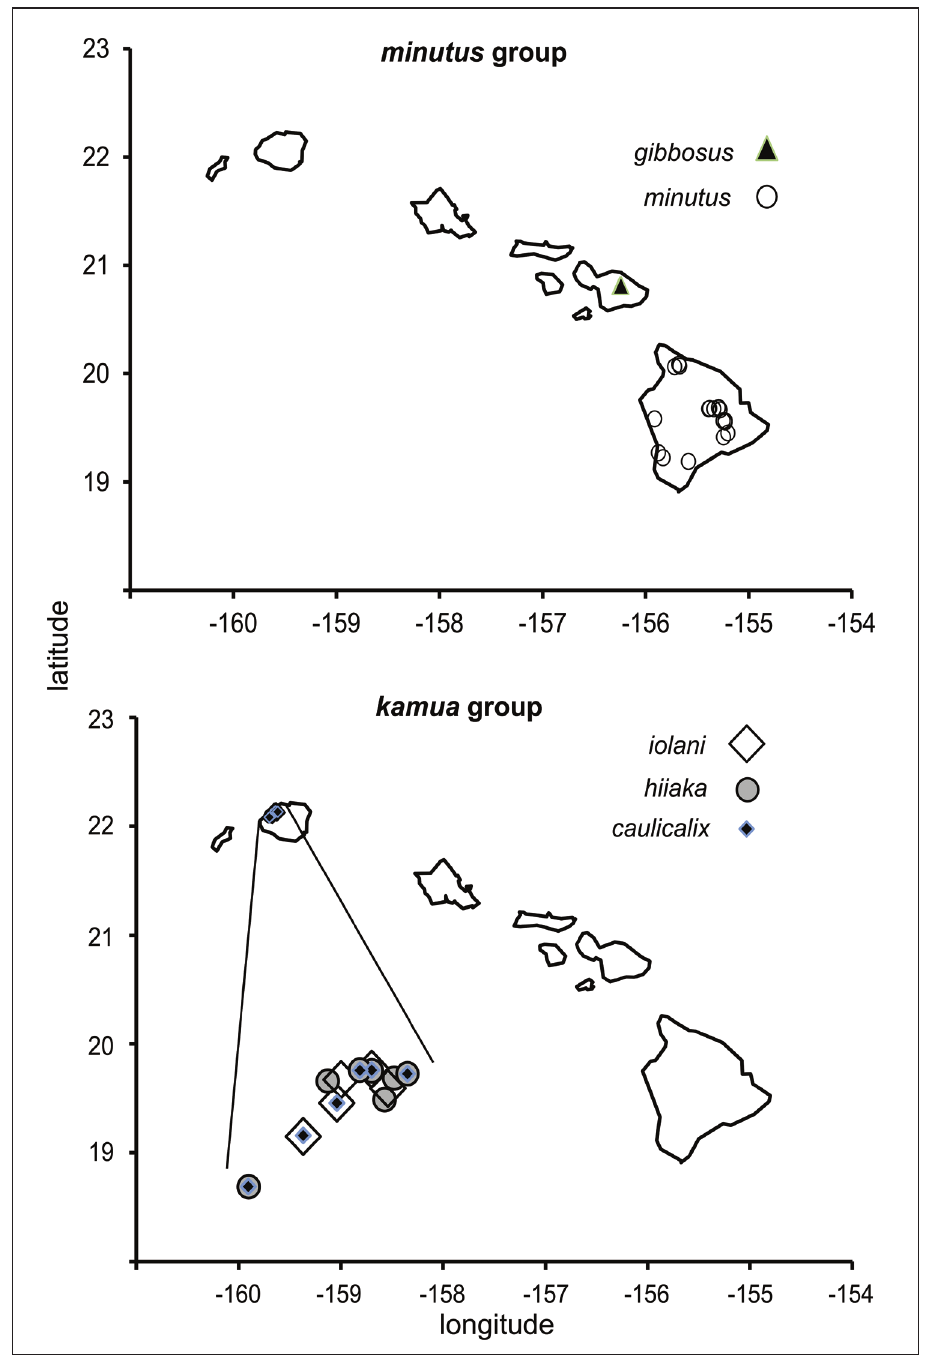
Figure 54. Map indicating sampling sites for minutus and kamua groups ( kamua group taxa not mapped here were all found within the same limited geographic